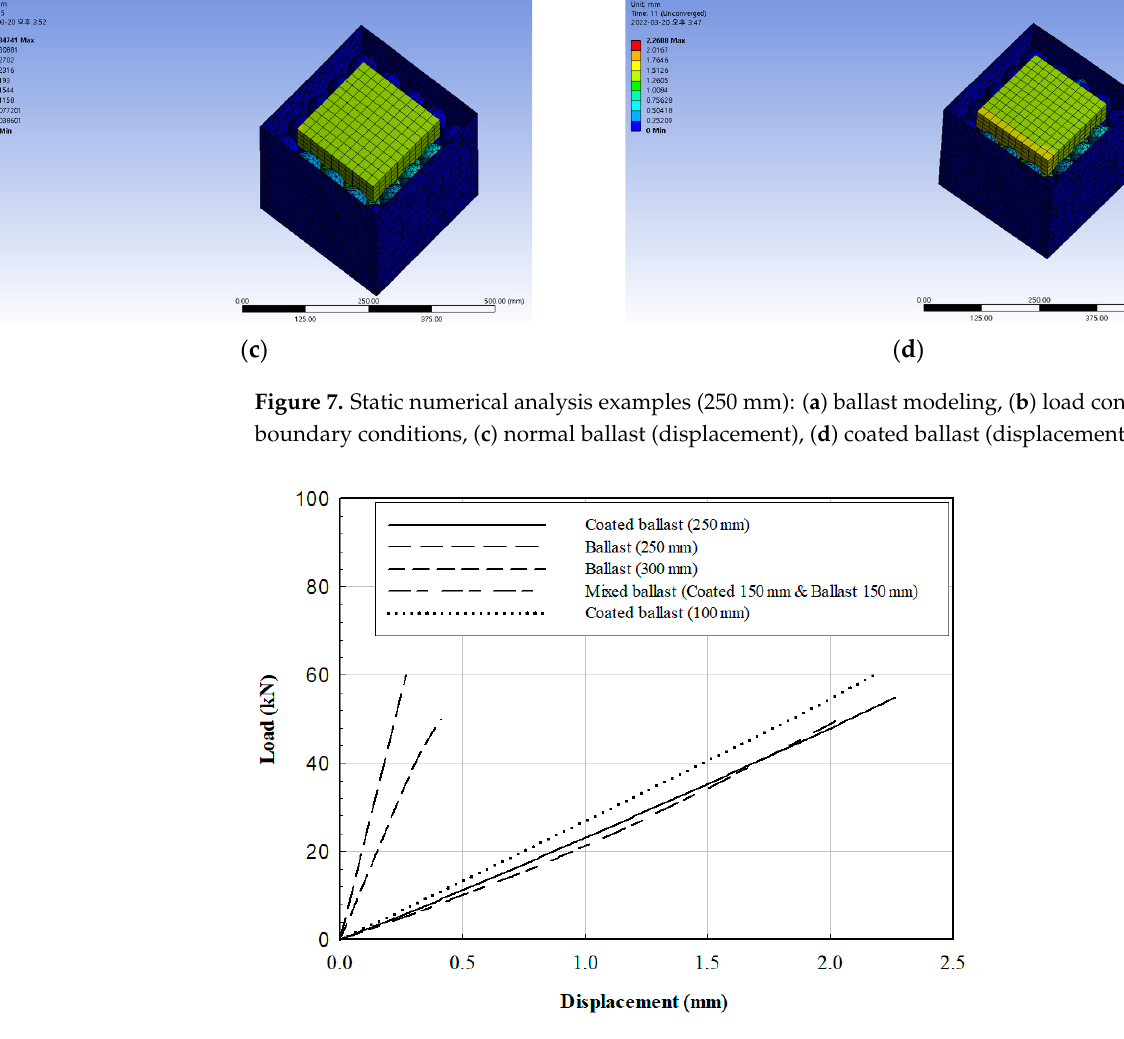
Figure 8. Results of numerical analysis of the ballast under each load condition. Table 1. Material and mechanical